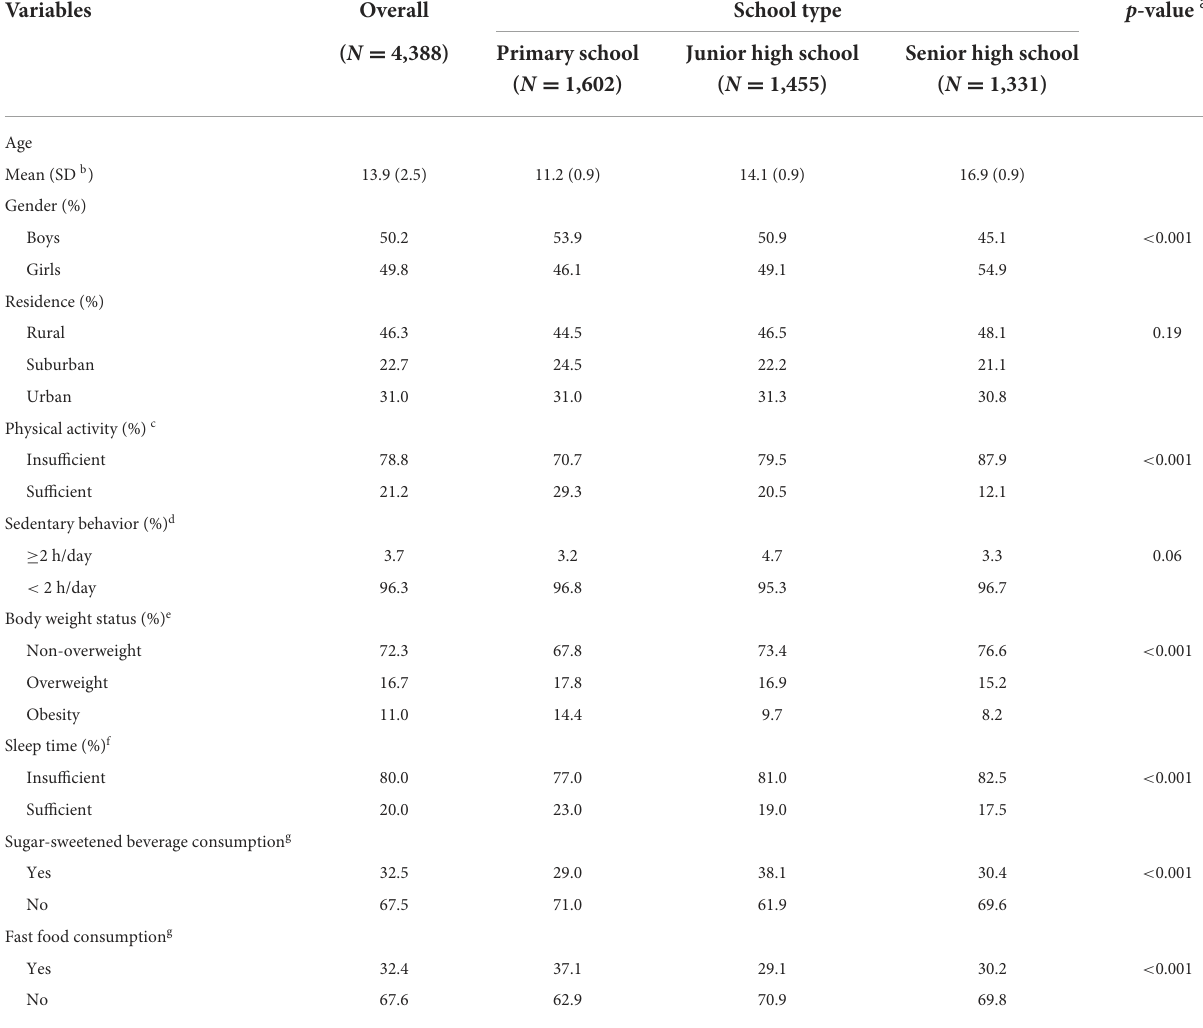
TABLE 1 Selected characteristics of participants by school type in this